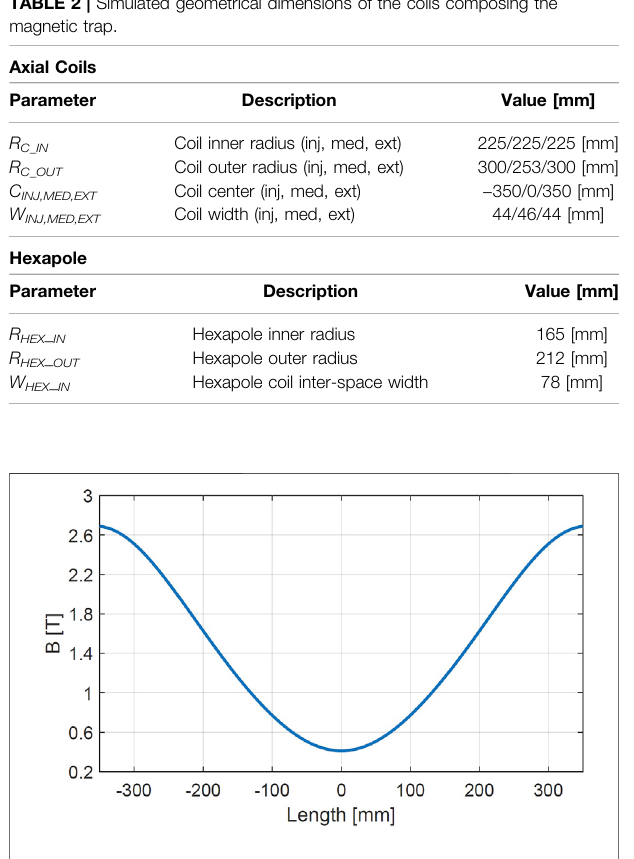
FIGURE 4 | Magnetic fi eld module, | B |, along plasma chamber z -axis for pumping frequency f RF = 18 GHz.